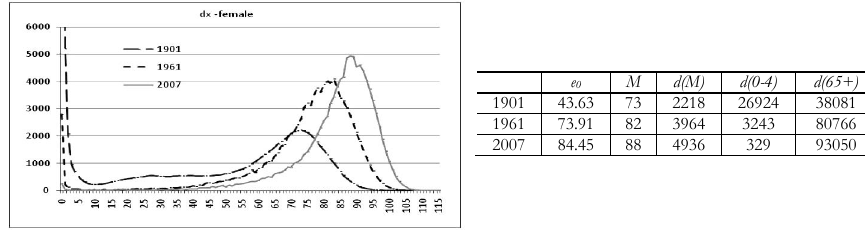
Figure 7 – Distribution of life table deaths in 1901, 1961 and 2007 and values of life expectancy( e 0 ), late modal age at death ( M ), modal number of deaths ( d ( M )), infant ( d ( 0-4 )) and elderly ( d ( 65+ )) deaths in the same years. Emilia Romagna –